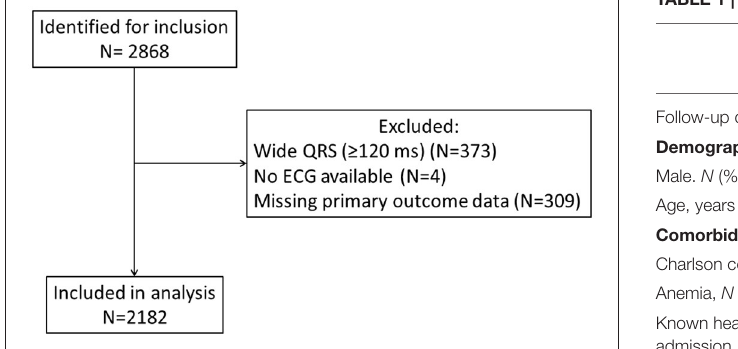
TABLE 1 | Baseline characteristics and follow-up durations of included